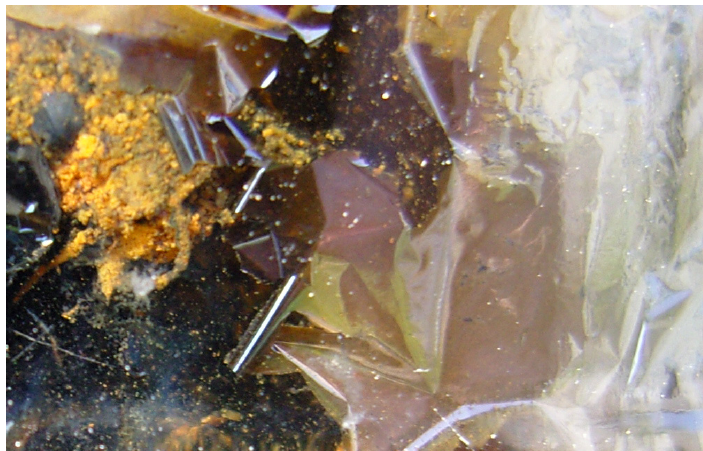
Figure F1. Corrosion features associated with fibrous (0.1 mm diameter) Fe 0 in saline water [PS14], photographed following conclusion of the desalination trial. Black = water filled porosity. Orange/yellow spheroids = hydrated β -FeOOH· m H 2 O (Fe 3+ O(O, Cl)) formed by precipitation of Fe 3+ ions in the water. Dark grey nodules surrounded by orange spheroids = bog iron (Fe 3 O 4 , magnetite). Off white to green and purple sheets growing into the water from the bright white rods = mixed valance green rust complex (Na I ( a=1 − c − b ) Fe II ( b=1 − c − a ) Fe III c (OH) 2 ] x − ·[( x / n )Cl n − · m H 2 O] x + , where a + b + c = 1) formed from the accretion of Fe 2+ and Fe 3+ ions in the water. The bright white rods of Fe(OH) 2 pseudomorph after and surround a Fe 0 core. They are the initial corrosion product. They are initially replaced at the water interface by purple, β -FeOOH. These act as a template for green rusts (Na I ( a=1 − c − b ) Fe II ( b=1 − c − a ) Fe III c (OH) 2 ] x − ·[( x / n )Cl n − · m H 2 O] x + , where a + b + c = 1) sheets. The green rusts are gradually replaced by ( β -Fe 3+ O(O, Cl)· n H 2 O). The increase in the proportion of Fe III species is initially signified by a rusty purple color which is then replaced by a yellow color when the precipitate is dominated by highly hydrated FeOOH· m H 2 O. The purple FeOOH becomes increasingly yellow in color with increased hydration. Fe corrosion species in this photograph have been identified by their color and morphology. The left edge (centre) of the photograph truncates a trapped hydrogen gas bubble. The formation of the grey precipitate is associated with the upper surface of the gas bubble. Field of view = 2 cm. The common colors of the various Fe 2 O 3 , Fe 3 O 4 corrosion species are: (i) hematite = red; (ii) maghemite = reddish brown; (iii) magnetite = black; (iv) goethite = yellow brown; (v) = lepidococite = orange; (vi) ferrihydrite = red-brown; (vii) akaganeite = purple to red brown/purple to orange/yellow; (viii) layered double hydroxides (white and green rusts) = white to green. The purple colour indicates the incorporation of Na + (see Appendix